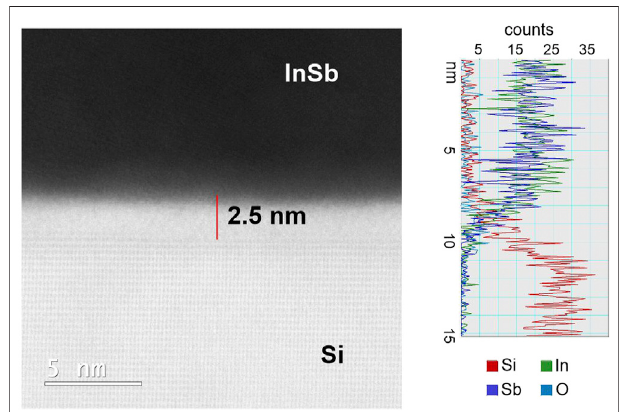
FIGURE 5 | High-resolution (S)TEM image of the Si — InSb interface for recrystallized sample together with EDX